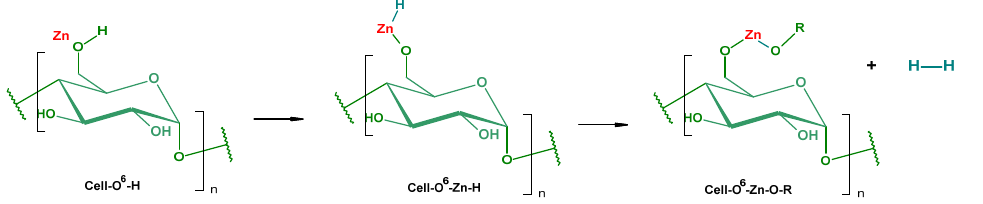
Figure 4. Putative mechanism of the reaction of zinc with cellulose during sputtering deposition of zinc on cotton.